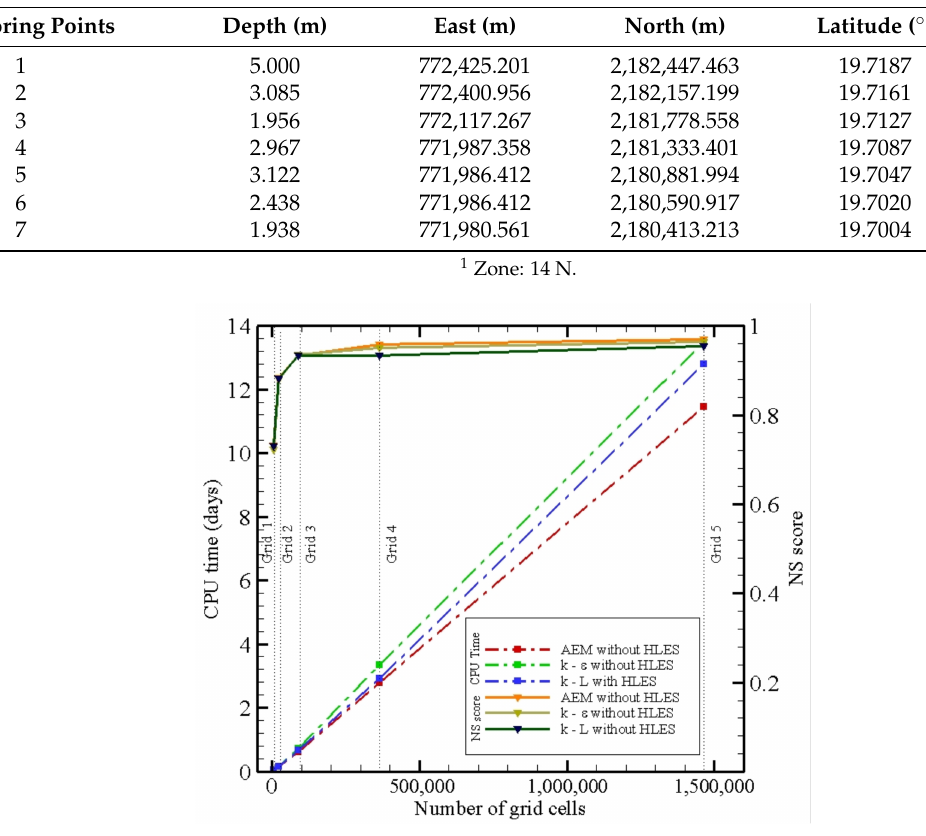
Figure 3. NS score obtained and CPU time for mesh independence analysis.